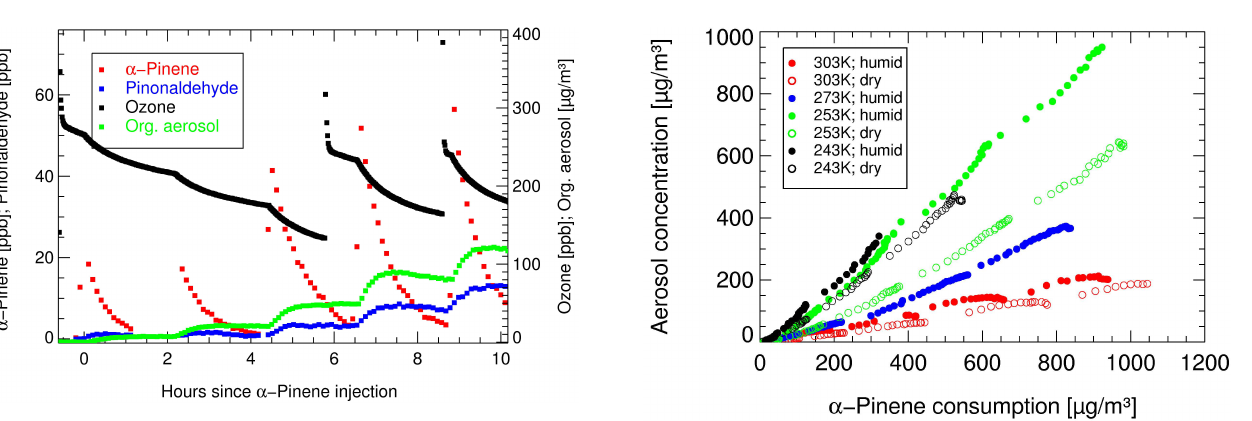
Fig. 3. Growth curves for the α -pinene ozonlysis for different tem- peratures and at low (open symbols) and high relative humidity (filled symbols). Curvature and discontinuities are caused by the section character of the experiments as shown in Fig. 2. α –Pinene was measured by PTRMS, aerosol concentration was derived from